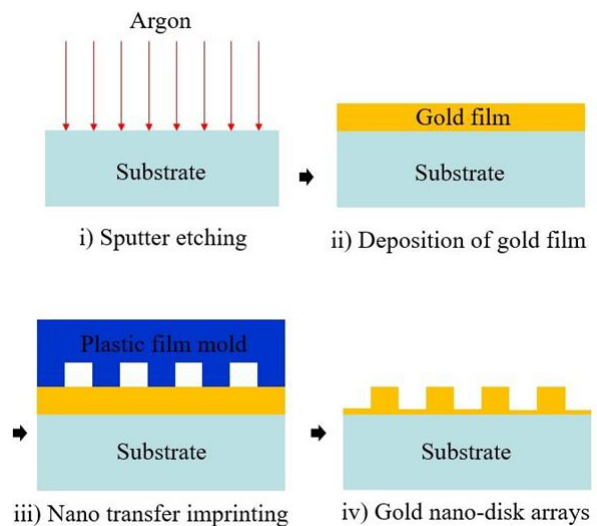
Figure 5. Fabrication process of metallic micro-disk arrays by mean of a PET film mold for the transfer imprinting method.